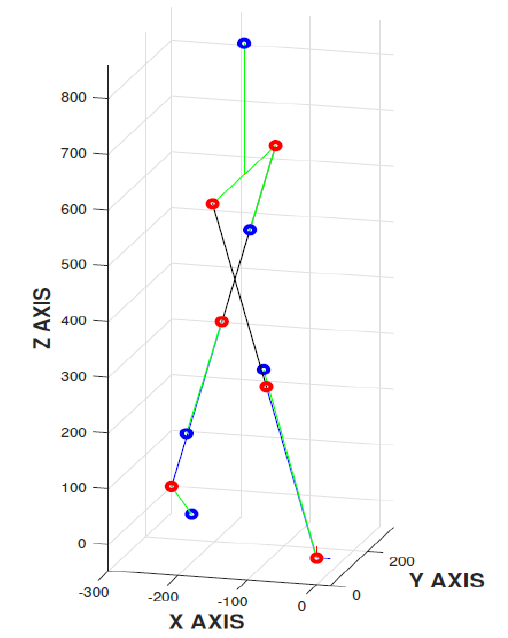
Figure 3. Kinematic model